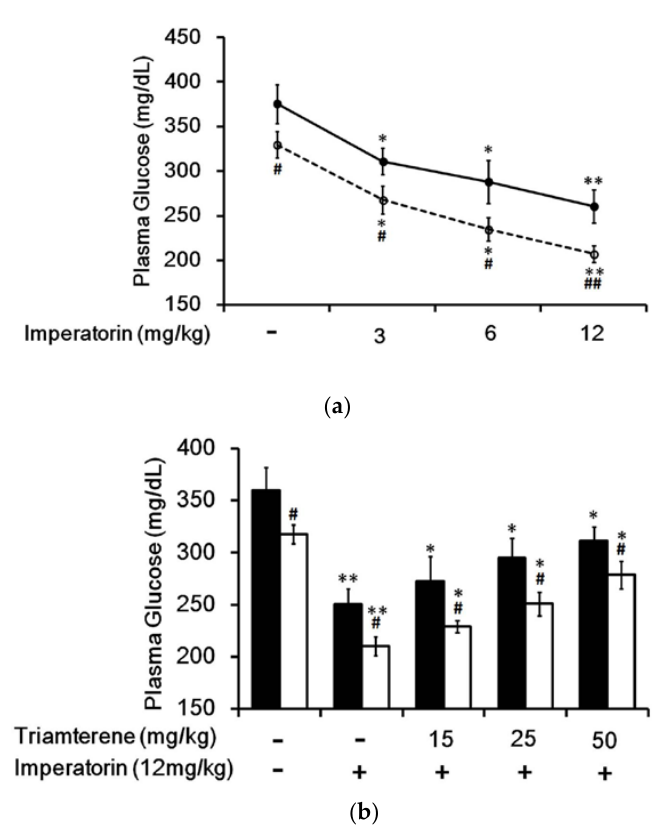
Figure 4. Effects of imperatorin on plasma glucose levels in type 1-like diabetic rats. ( a ) Plasma glucose levels were determined 1 h after the administration of imperatorin at the indicated dose in the vehicle-treated group (solid line) or the sitagliptin-treated (5 mg/kg/day orally for 14 days) group (broken line). ( b ) The inhibitory effects of triamterene on imperatorin-induced reductions in plasma glucose levels in diabetic rats receiving vehicle (black column) or sitagliptin (open column) at 5 mg/kg/day orally for 14 days. These diabetic rats were pretreated with triamterene at the indicated dose for 30 min. The values are expressed as the mean ± SEM obtained from eight samples per group. "-" is presented as 0 mol/L; "+" is presented as imperatorin treatment. * p < 0.05 and ** p < 0.01 compared with the vehicle-treated group. # p < 0.05 and ## p < 0.01 compared with the basal group without sitagliptin treatment.